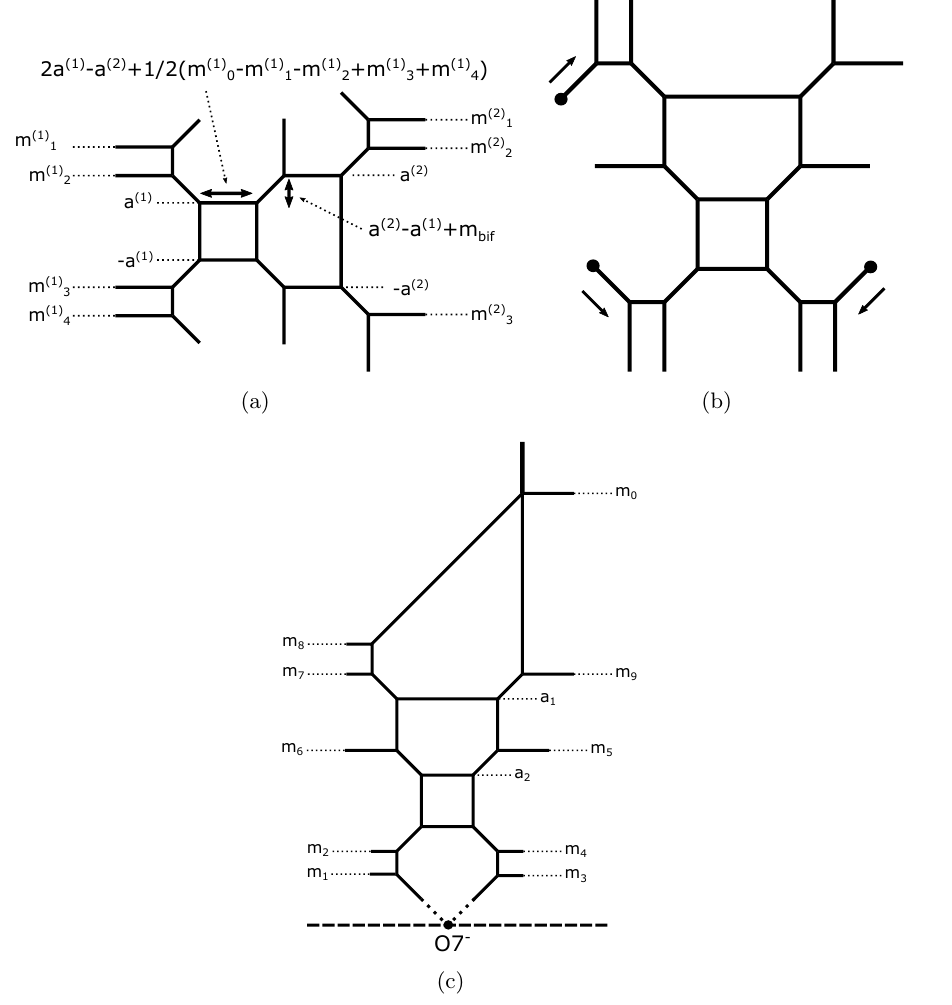
Figure 11 . (a). The 5-brane web diagram for the quiver theory [4] SU(2) SU(2) [3] and (cid:0) (cid:0) (cid:0) the gauge theory parameterization. (b). S-dual to the diagram in (cid:12)gure 11(a). The black dots represent 7-branes. (c). The 5-brane web diagram for the Sp(2) gauge theory with 9 (cid:13)avors and the gauge theory parameterization. The black dot in this (cid:12)gure represents an O7 (cid:0) -plane. The Sp(2) gauge theory with 9 (cid:13)avors has another dual frame given by the quiver gauge theory [4] SU(2) SU(2) [3]. It is also possible to obtain the duality map using (cid:0) (cid:0) (cid:0) 5-brane webs in (cid:12)gure 11. The diagram in (cid:12)gure 11(a) shows the parameterization for the SU(2) SU(2) quiver theory. The S-dual of the diagram is simply given by rotating (cid:2) the diagram by (cid:25) as in (cid:12)gure 11(b). We further move 7-branes in (cid:12)gure 11(b) in the directions indicated by the arrows in the (cid:12)gure so that we can read o(cid:11) the parameterization of the Sp(2) gauge theory. The resulting diagram after moving the 7-branes is given in (cid:12)gure 11(c). In order to see the parameterization in terms of the Sp(2) gauge theory, the (cid:13)avor mass parameters and the Coulomb branch moduli should be measured from the location of an O7 (cid:0) -plane. The parameterization of the Sp(2) gauge theory can be read o(cid:11)